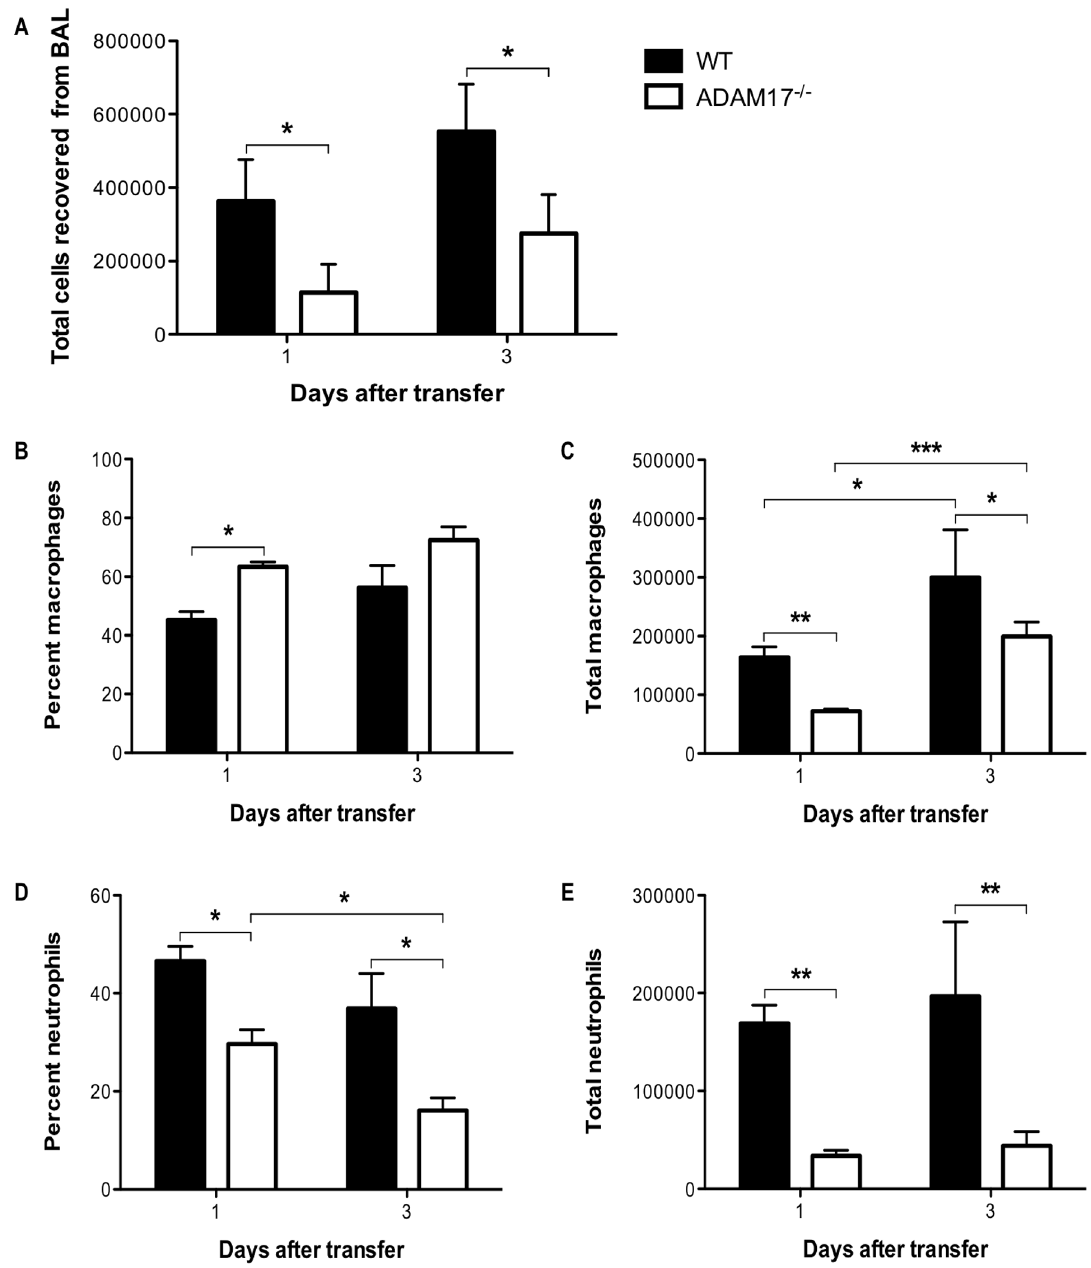
Figure 7. ADAM17 expression on transferred CD8 + T cells is required for enhanced airway infiltration. SPC-HA transgenic mice received 10 7 WT or ADAM17 2 / 2 HA-specific CD8 + T cells via tail vein injection. (A) On the days indicated, cells were recovered from BAL and counted on a hemocytometer with trypan blue exclusion to determine the total number of viable cells. Percentage of (B) macrophages and (D) neutrophils was determined by morphological analysis of cells after staining cytospin preparations. Absolute number of (C) macrophages and (E) neutrophils was calculated by multiplying the percent of cells by the total number of cells recovered from BAL. Data represent mean 6 standard deviation. Data are representative of two or more independent experiments with 3-4 mice per group. * P , 0.05, ** P , 0.01, *** P , 0.001.